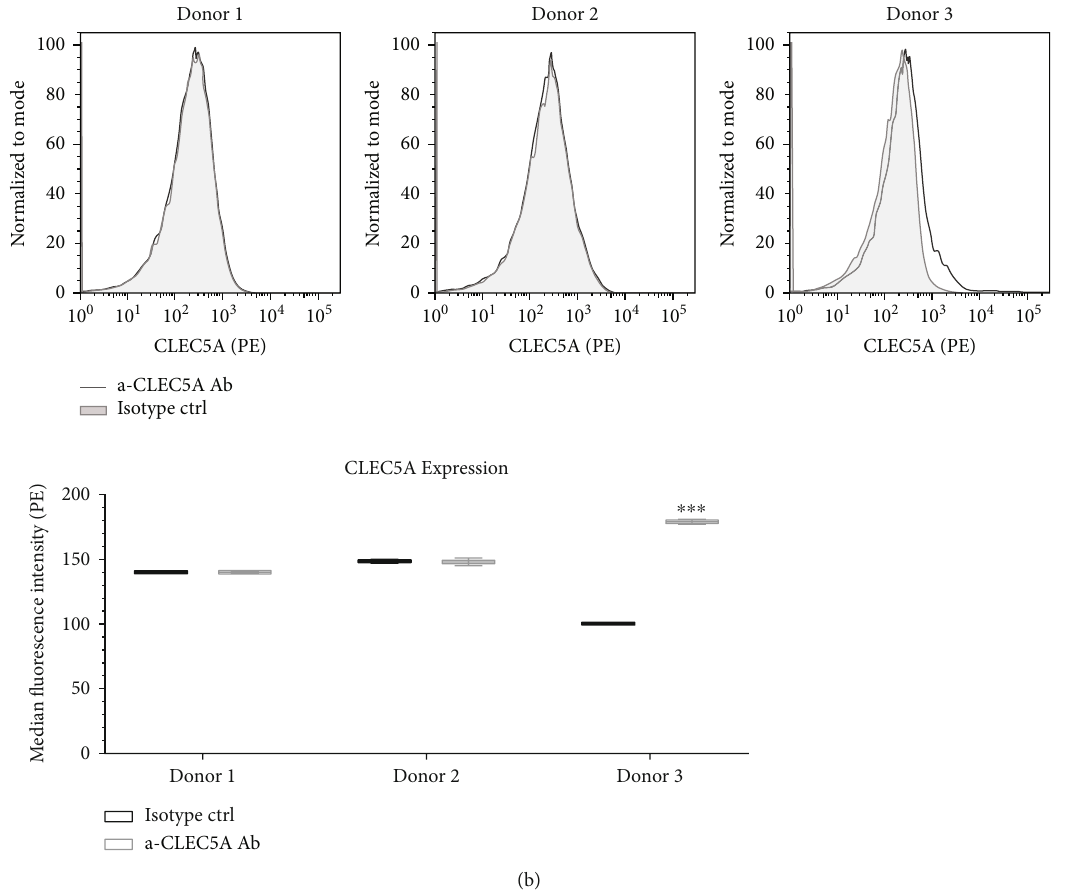
Figure 4: CLEC5A expression is elevated on proin fl ammatory M1 MdM while minimal on tumor-associated macrophages. (a) Human monocytes from 3 healthy donors were terminally di ff erentiated into several subsets of monocyte-derived macrophages (MdM): M1, M0, M2c, and TAM. 5 x 10 4 cells in 100 μ L/well were FACS stained with a PE-labelled α -CLEC5A Ab (1 :40, grey line) or with isotype ctrl (1 :40, grey shadow). Histograms show representative stainings from one of three donors per condition. (b) Macrophages isolated from the ascites fl uid collected from three patients with advanced ovarian carcinoma were FACS stained at 10 5 cells in 100 μ L/well with a PE- labelled α -CLEC5A Ab (1 :40, grey line) or with isotype ctrl (1 : 40, grey shadow). Data represent three individual donors tested in technical duplicates. The CLEC5A expression is shown as an antibody vs isotype histogram overlay (upper panel) or as median fl uorescence intensity (MFI) of the CLEC5A Ab staining or isotype ctrl for each group tested (lower panel). Values represent the mean and SD of each donor; ∗ p < 0 : 033 , ∗∗ p < 0 : 002 , and ∗∗∗ p < 0 : 001